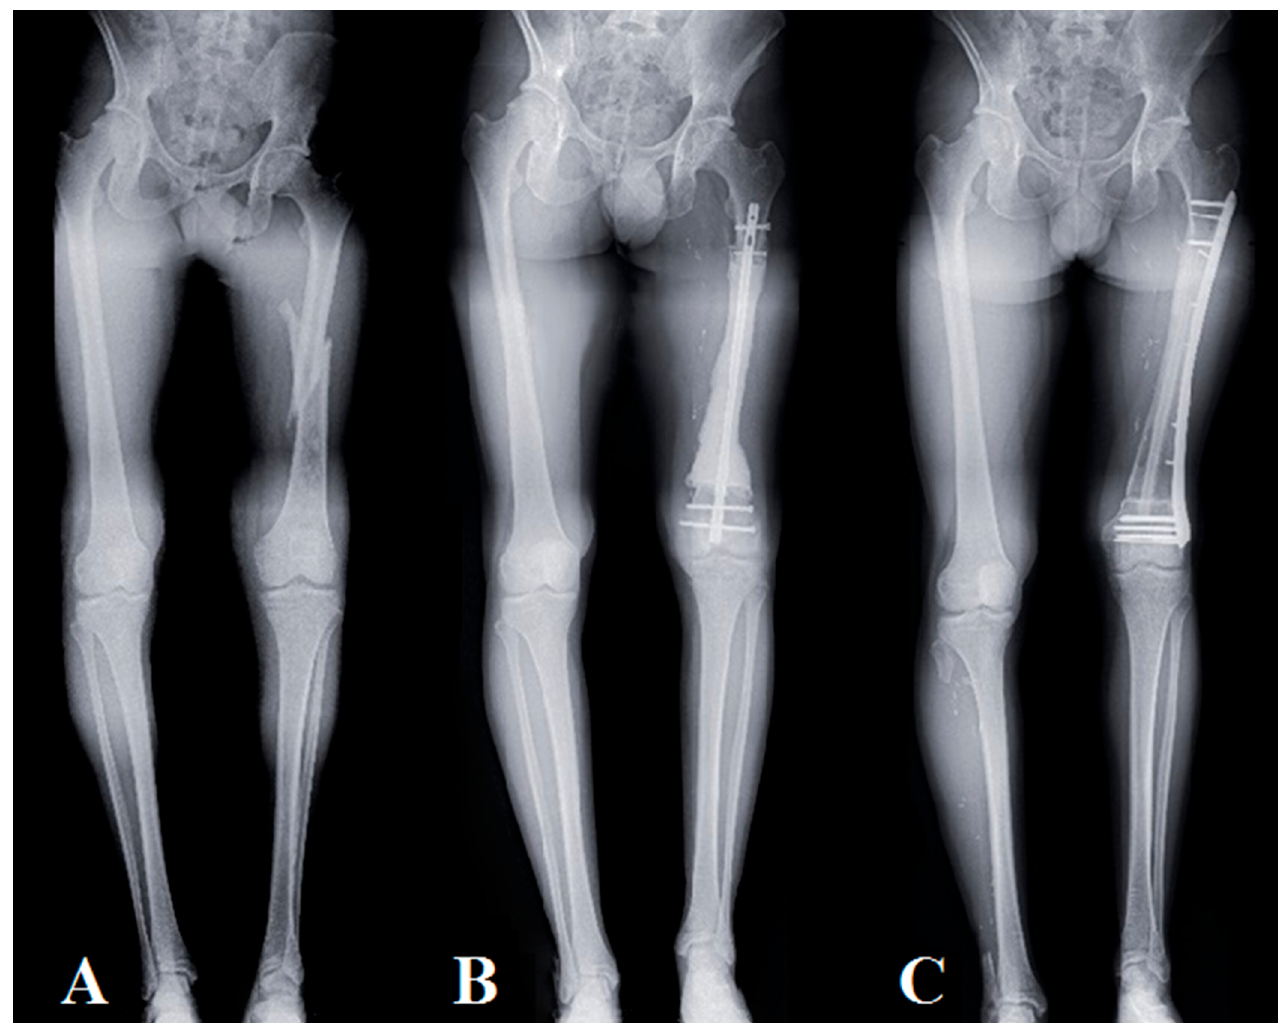
Figure 3. Progression of a Capasquelet technique reconstruction, using a pangonogram X-ray view, in a 28 year old patient with high-grade osteosarcoma (patient No. 2): ( A ) preoperative X-ray, fractured high-grade osteosarcoma with a length inequality of 80 mm; ( B ) postoperative X-ray of the 1st surgical stage after carcinologic resection and placement of the spacer on an intramedullary nail with a length inequality of 60 mm (post-T1 delay: 1 month); ( C ) postoperative X-ray at 1 year, residual lower limb inequality of 40 mm.